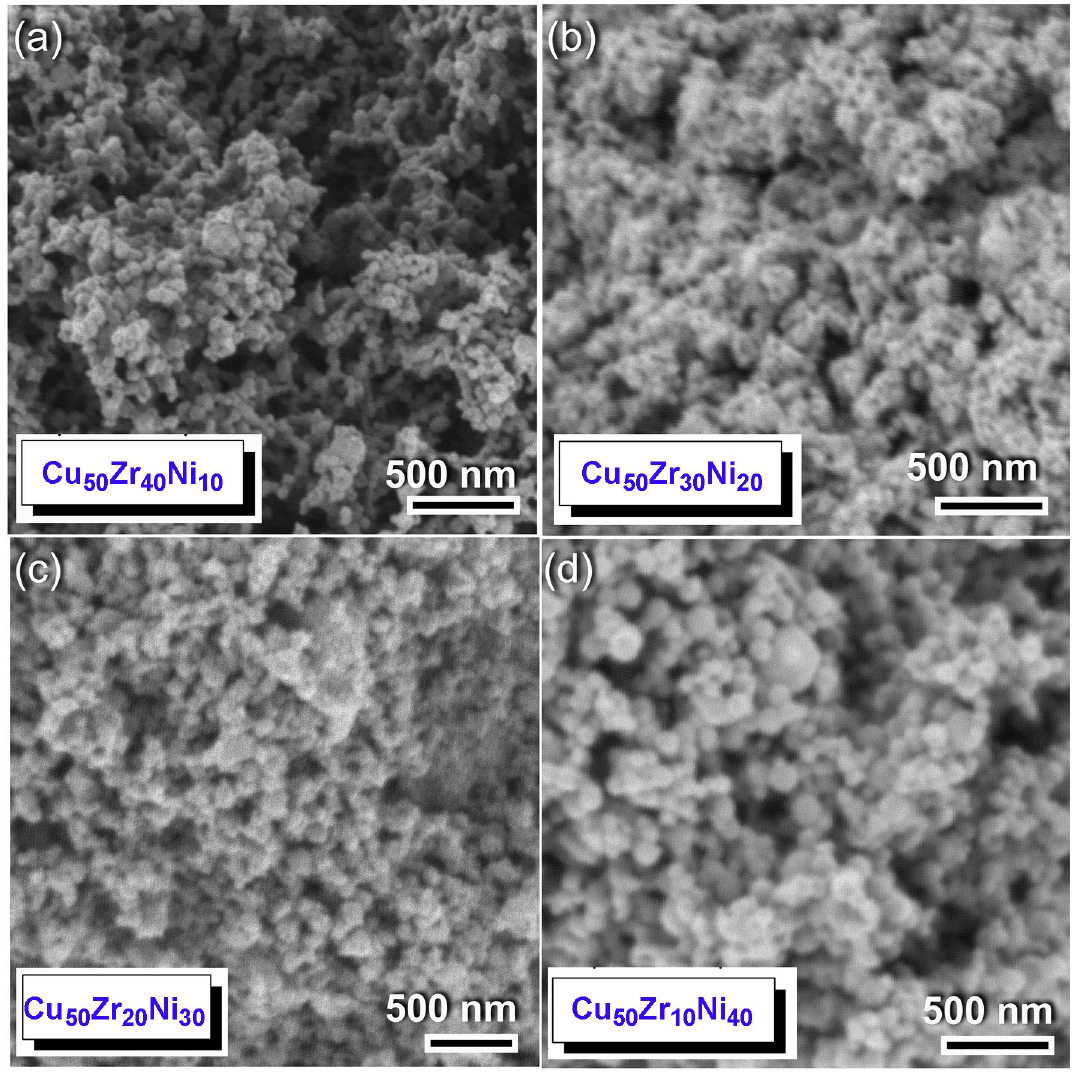
Figure 4. Morphological characteristics of Cu 50 (Zr 50−x Ni x ) powders obtained after 50 h of MA time. The FE-SEM images of the powders obtained after 50 of MA time are shown in ( a ), ( b ), ( c ), and ( d ) for Cu 50 Zr 40 Ni 10